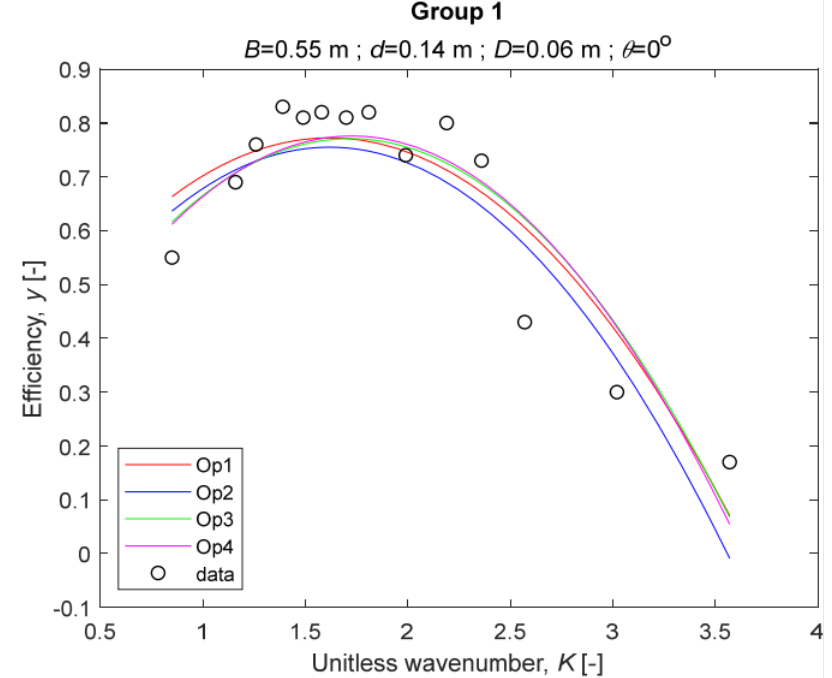
Figure 3. The four models for Group 1.